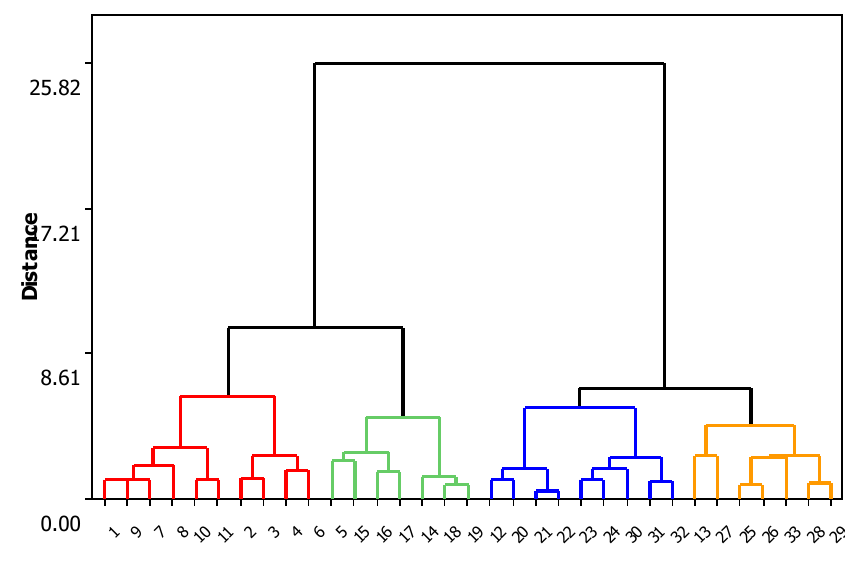
Figure 6. Dendrogram of the power plant water by cluster analysis based on Ward Linkage and Euclidean Distance.